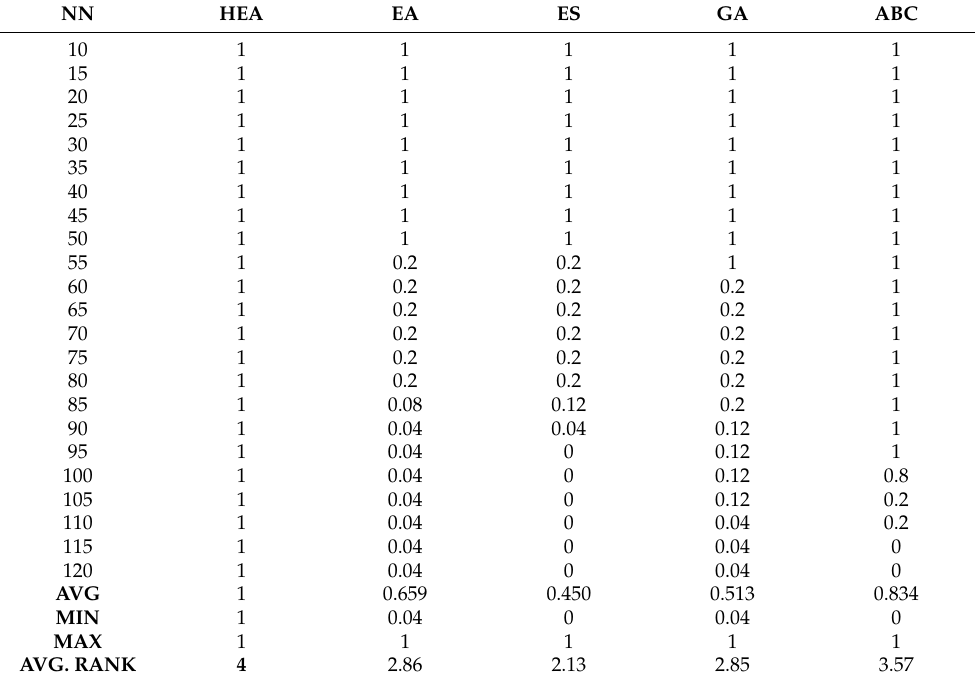
Figure 8. Ratio Global Solutions ( RGS ) for different DHNN-RAN k SAT models. Table 8. Tabulated values of RGS for different DHNN-RAN k SAT models.